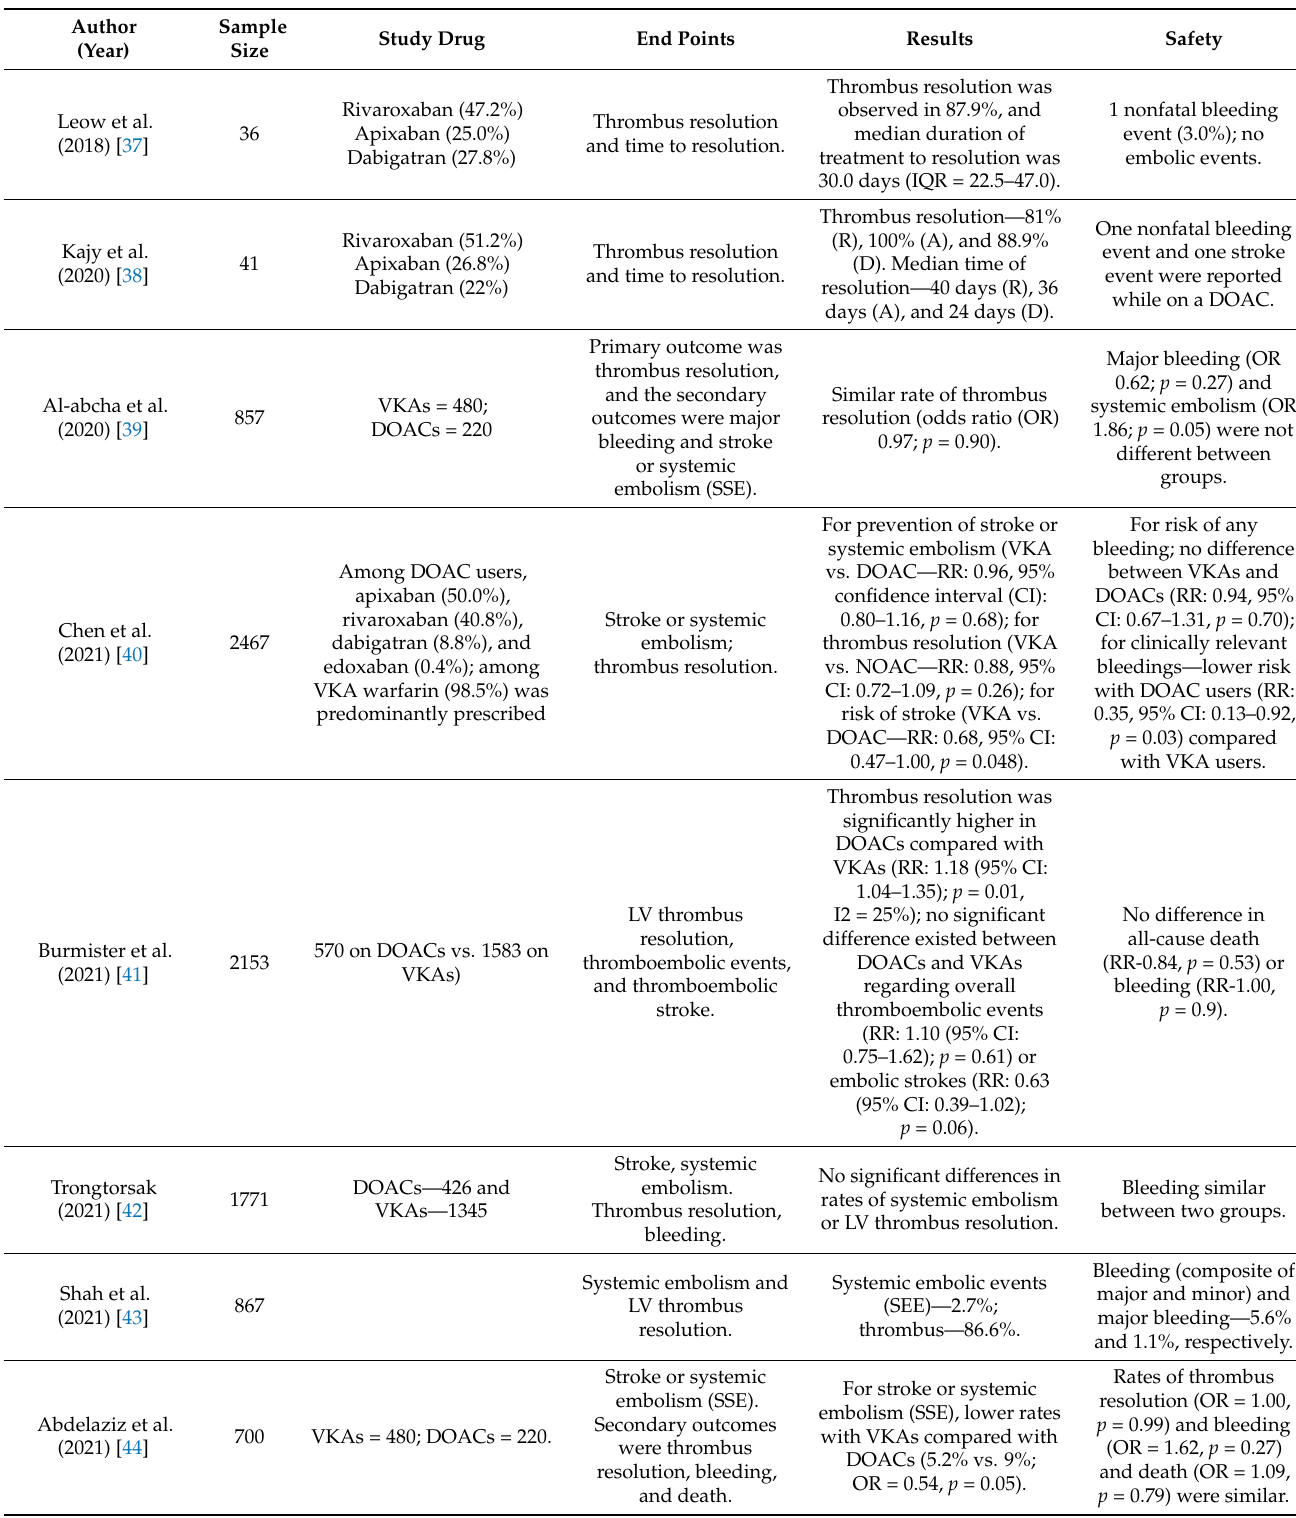
Table 3. Meta-analyses, meta-summaries, and systematic reviews comparing DOAC therapy and VKA therapy in setting of LV thrombus following MI. Notes: IQR—interquartile